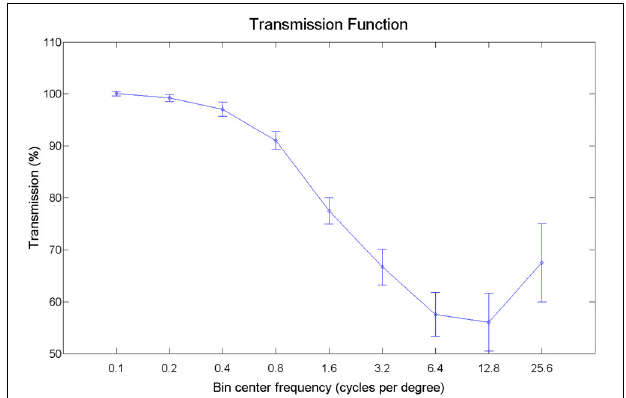
FIGURE 9 | Transmission plot. The energy per spatial frequency in the filtered images expressed as a percentage of the energy in the original images, averaged over orientations.